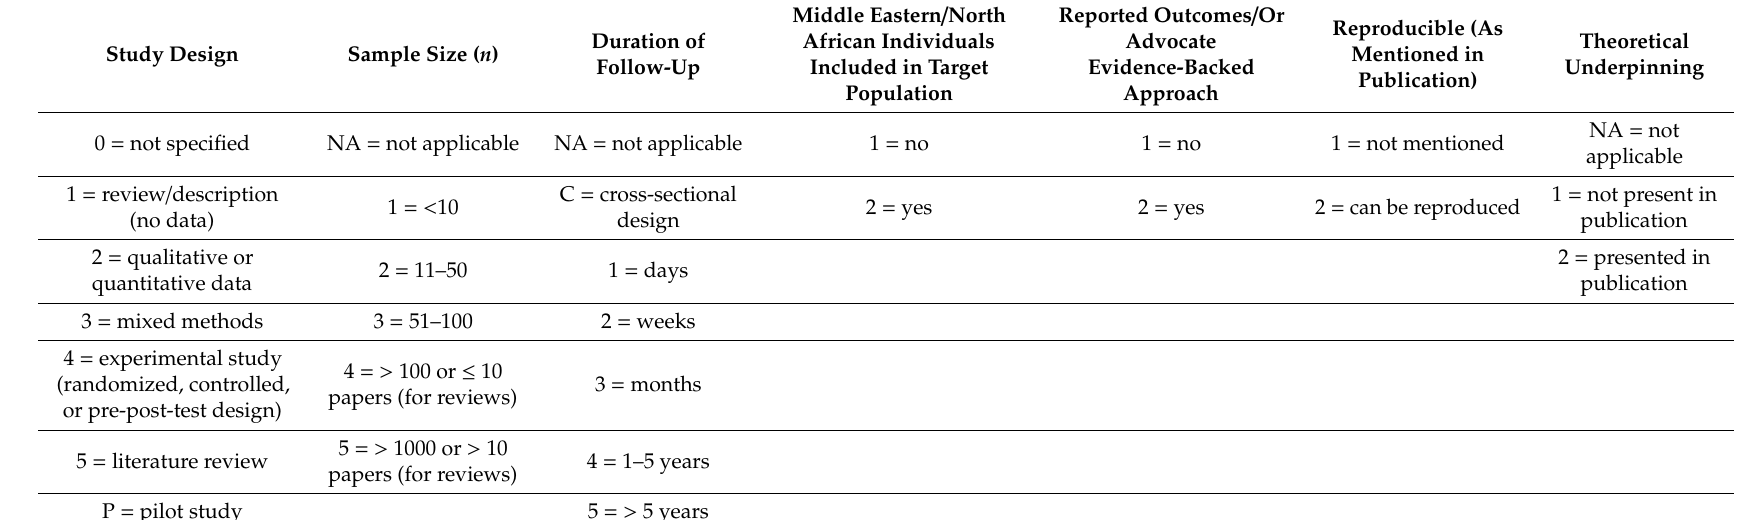
Table 1. Evaluation criteria of selected interventions on community-based best